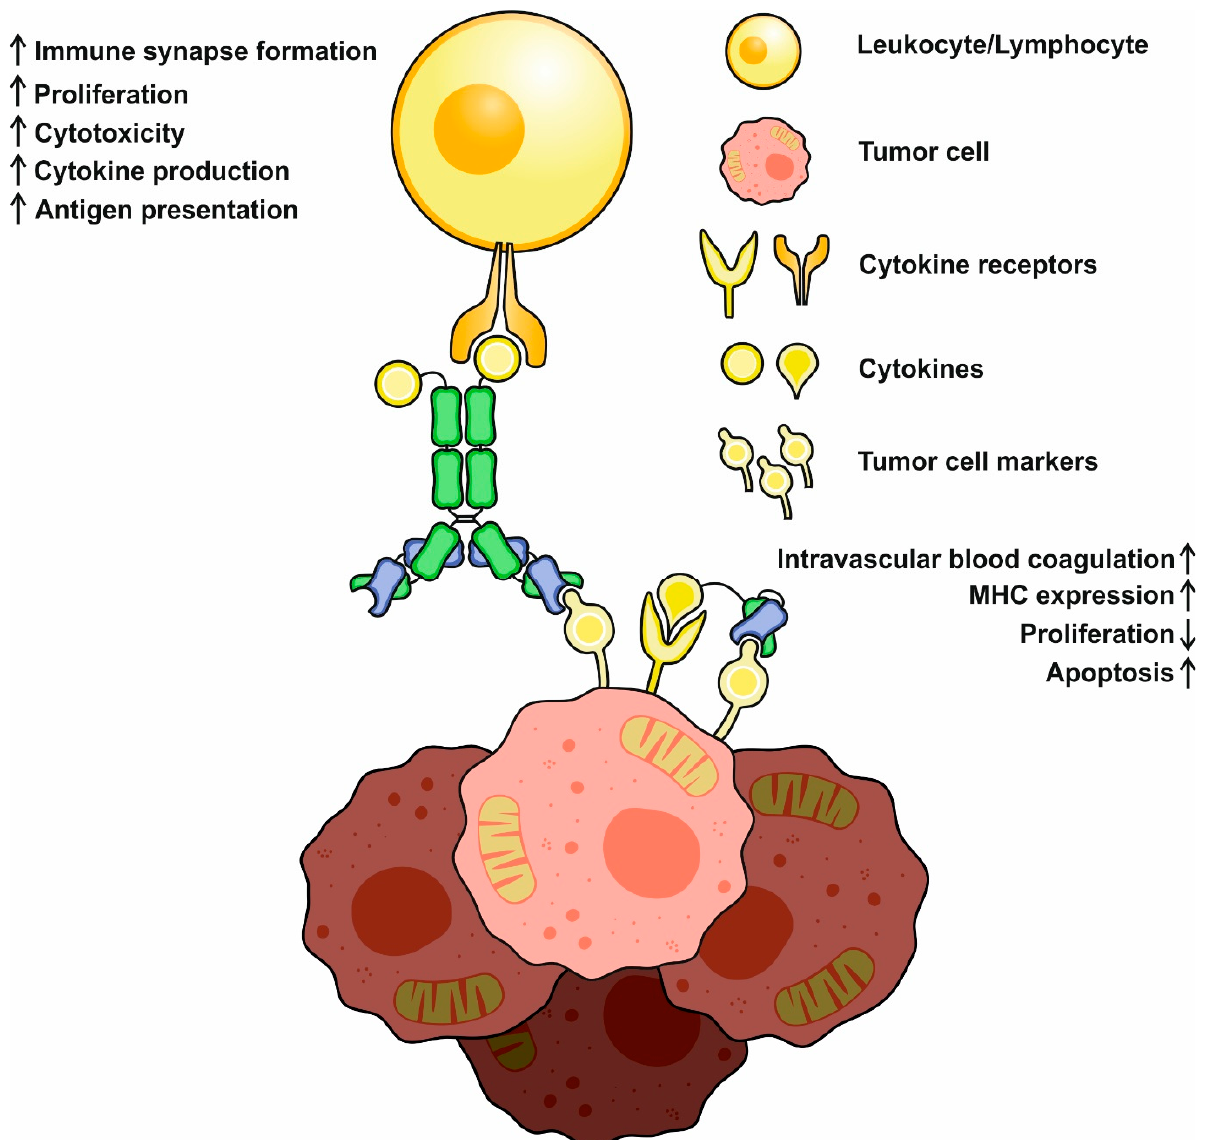
Figure 2. A schematic representation of basic mechanisms of immunocytokine action. Cytokines may activate and redirect immune system cells to tumor cells and initiate immune synapse formation. Activated immune cells increase ( ↑ ) in cytotoxicity, cytokine production, and proliferation. Direct action of cytokines decreases ( ↓ ) tumor cell propagation, increases MHC expression and antigen presentation, and might activate proapoptotic pathways.